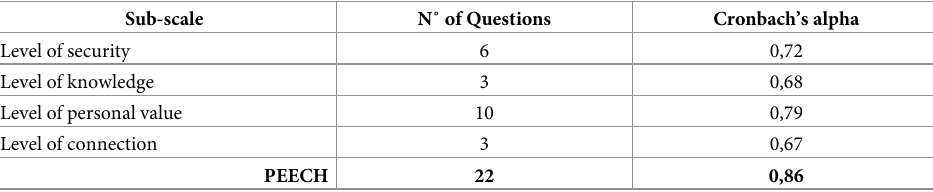
Table 5. Internal consistency of the PEECH questionnaire and each of its